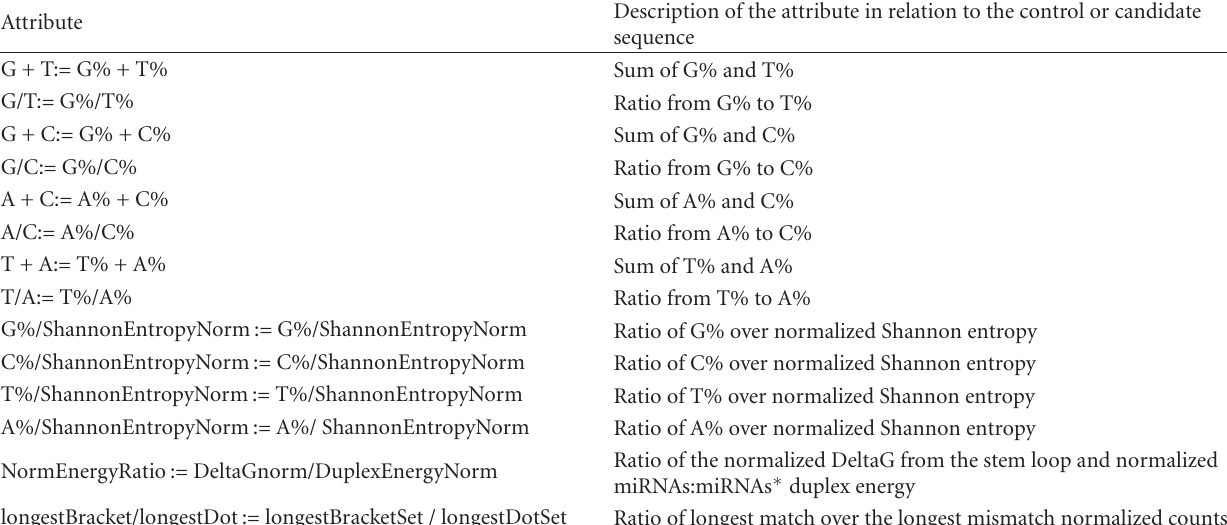
Table 4: Extended attribute set from combinations of base